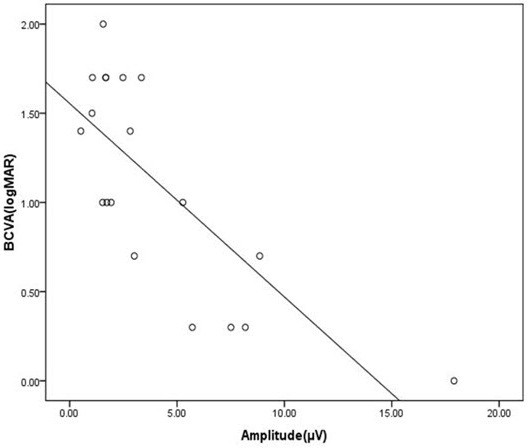
The correlation between amplitude and visual acuity of optic neuritis in pattern VEP. Pattern amplitude is plotted as a function of visual acuity. The correlation coefficient was -0.762, p = 0.0002, showing significant relation (y = -0.108x + 1.55).